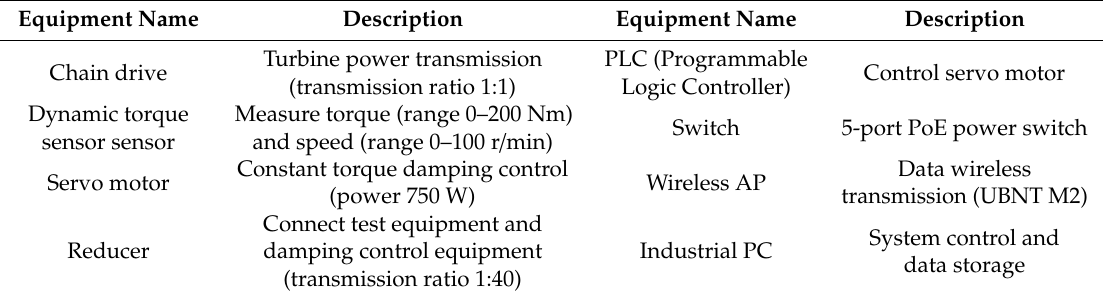
Table 3. Main equipment and function description of performance evaluation device.